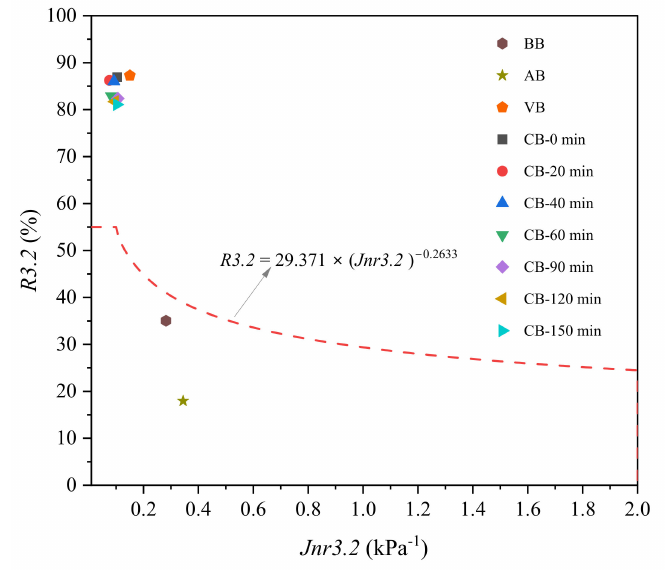
Figure 11. The results of R3.2 vs. Jnr3.2